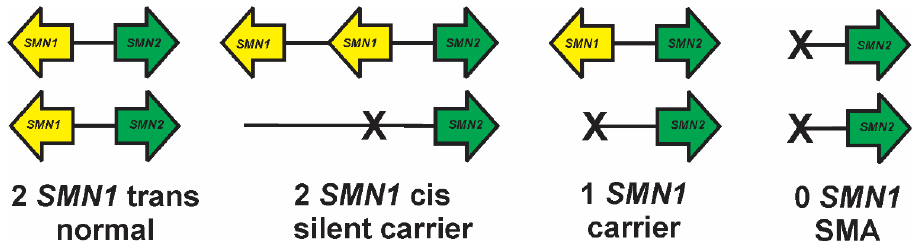
Figure 5. Allelic organizations of SMN1 copies within normal ( SMN1 :1+1), silent carrier ( SMN1 :2+0), carrier ( SMN1 :1+0) and SMA ( SMN1 :0+0) patients. SMN1 g.27134T>G (also known as SMN1 c.*3+80T>G) and SMN1 g.27706_27707delAT (also